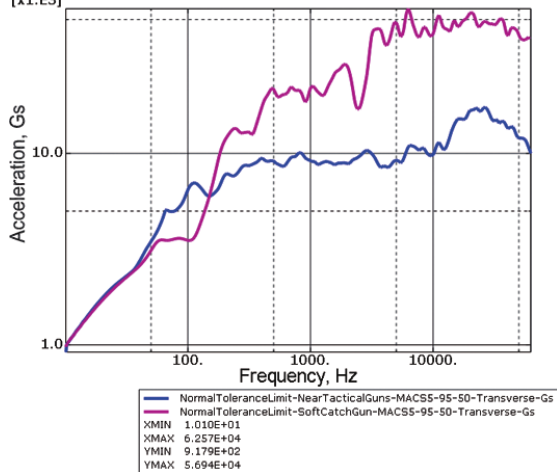
Fig. 11. Comparison of normal tolerance limits, macs 5 charge, ax- ial direction, Q = 10. (Purple curve is for the near-tactical shots; Red curve is from the Soft Catch Gun).